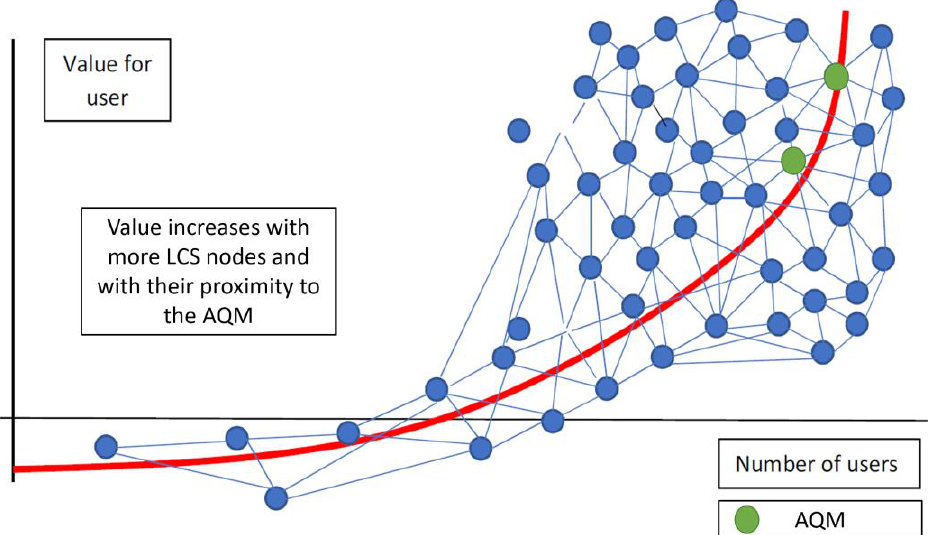
Figure 2. The value of the Smart Air Quality Network is proportional to both the square of the number of connected LCS devices and their spatial and temporal closeness to the existing official air quality monitoring network (AQM). These AQM stations are shown in green in the chart above.